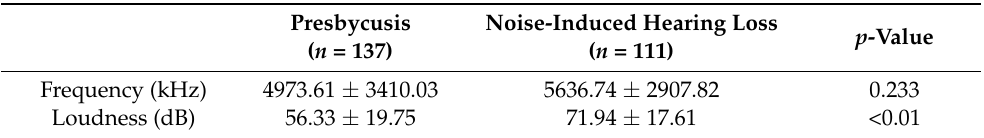
Results are reported as mean ± SD.